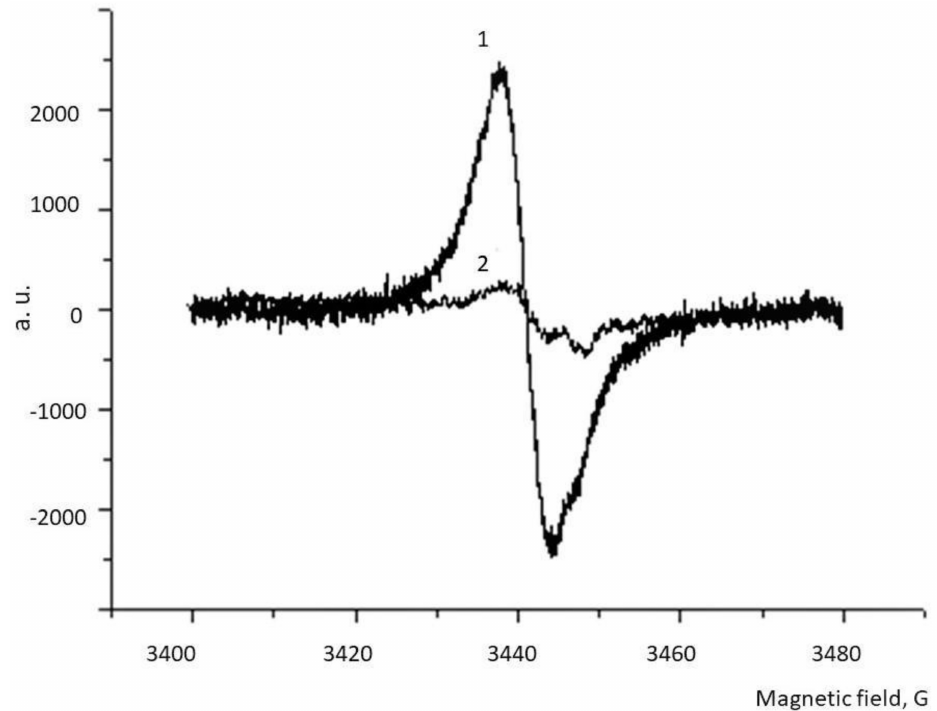
Figure 1. The ESR spectrum of water-soluble melanin from BSF. Curve 1—the initial spectrum; curve 2—after oxidation with 1% hydrogen peroxide solution for 2 h. a. u.—arbitrary